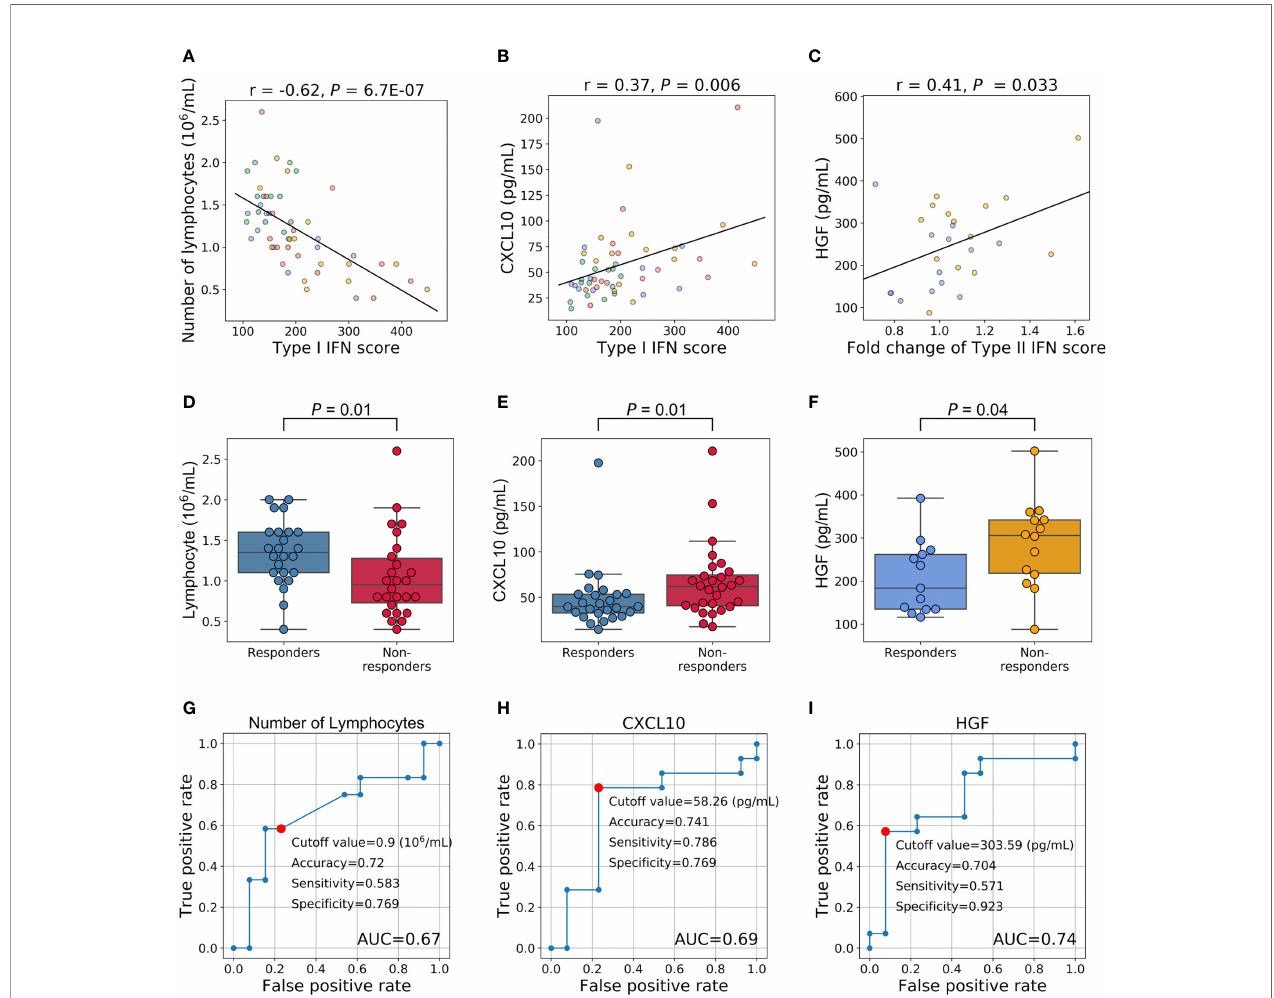
FIGURE 4 | Relationships between the IFN signature and other phenotypes and an evaluation of their clinical utility as predictive markers. (A – C) Relationships between IFN scores and other phenotypes. Each dot represents each specimen. Blue represents responders before treatment, orange for non-responders before treatment, green for responders three months after treatment, and red for non-responders three months after treatment. (D, E) Relationships between treatment responses and the number of lymphocytes and CXCL10 levels. Fifty-four specimens (27 samples × 2 timepoints) were analyzed. (F) Relationship between HGF levels before treatment and treatment responses. (G – I) ROC curves for no response to TNFi. Red plots indicate the cut-off points at the highest accuracy (minimum false negative and false positive results) for predicting